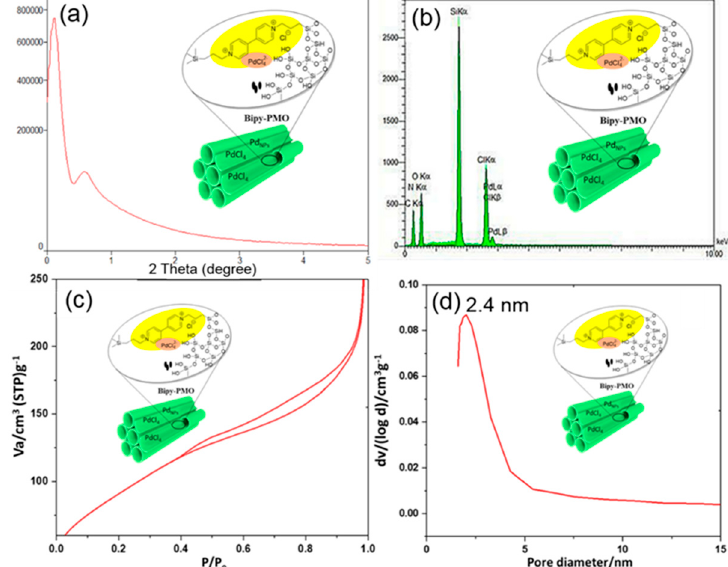
Figure 3. Pd@Bipy–PMO: ( a ) small angle X–ray diffraction (SAXRD) pattern, ( b ) EDX spectrum, and ( c ) nitrogen adsorption–desorption isotherms (BET) surface area and ( d ) Barrett–Joyner–Halenda (BJH) absorption.